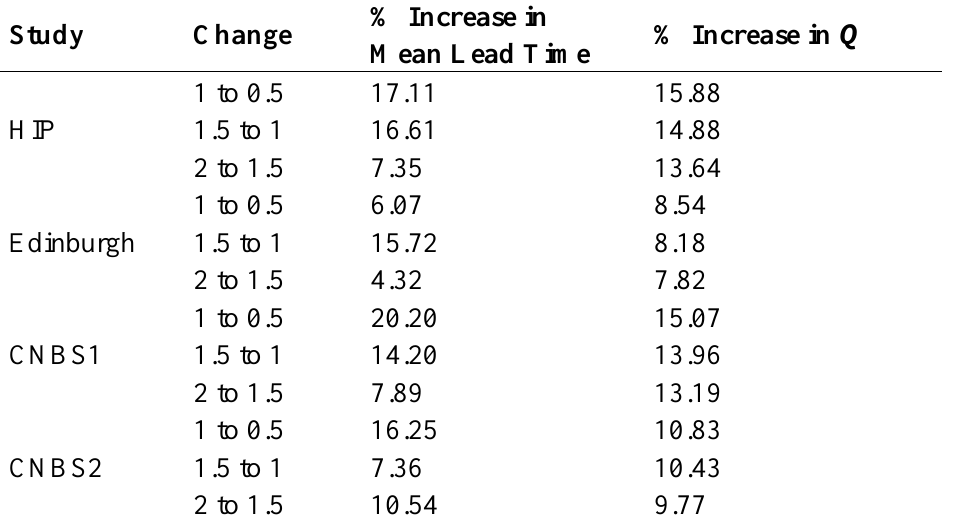
Table 3. Benefits of decreasing screening interval